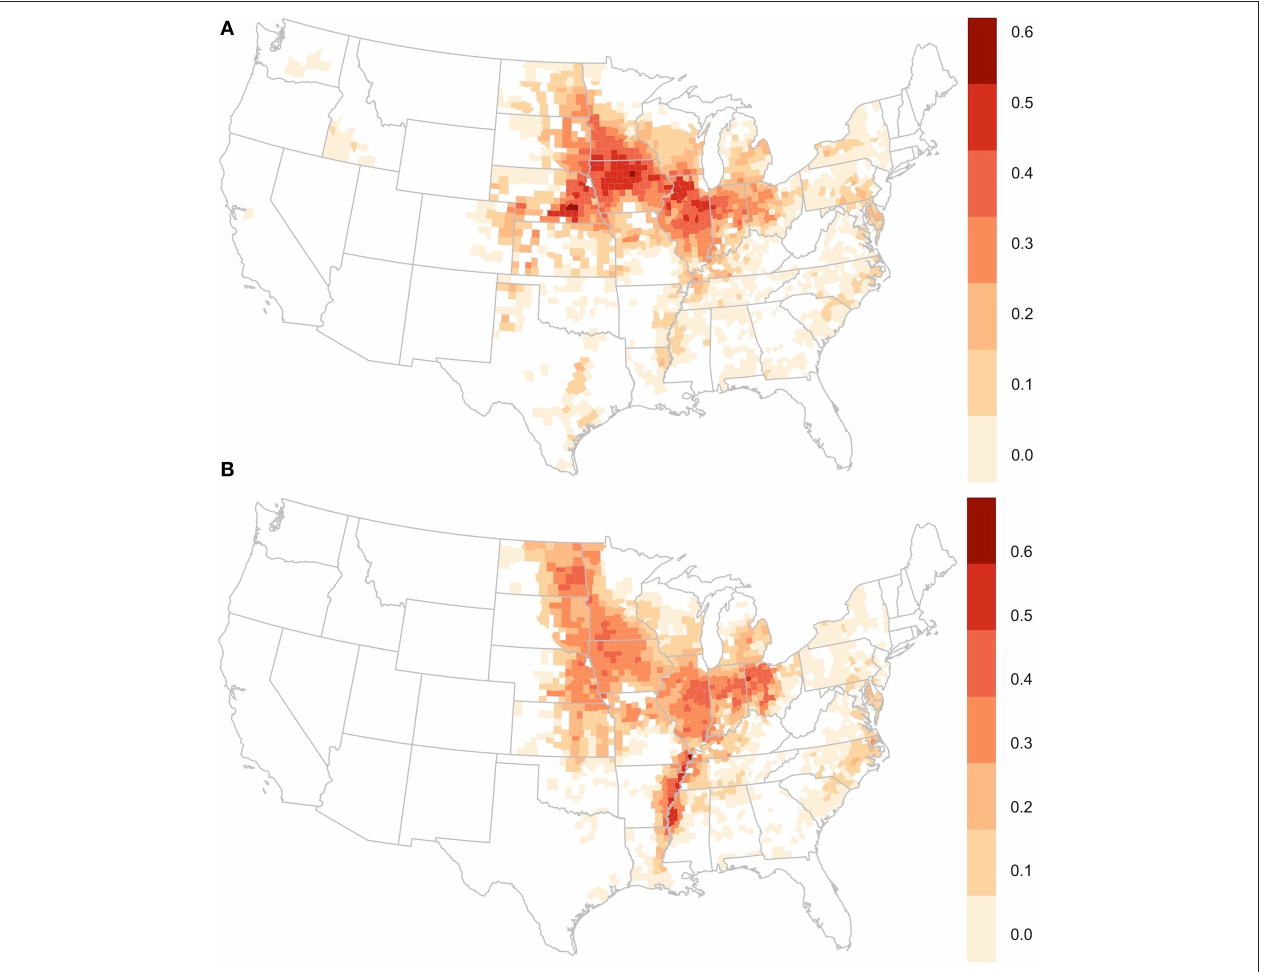
FIGURE 11 | (A) Percent of total county land cultivated with corn in 2017. (B) Percent of total county land cultivated with soybeans in 2017. Data: USDA NASS